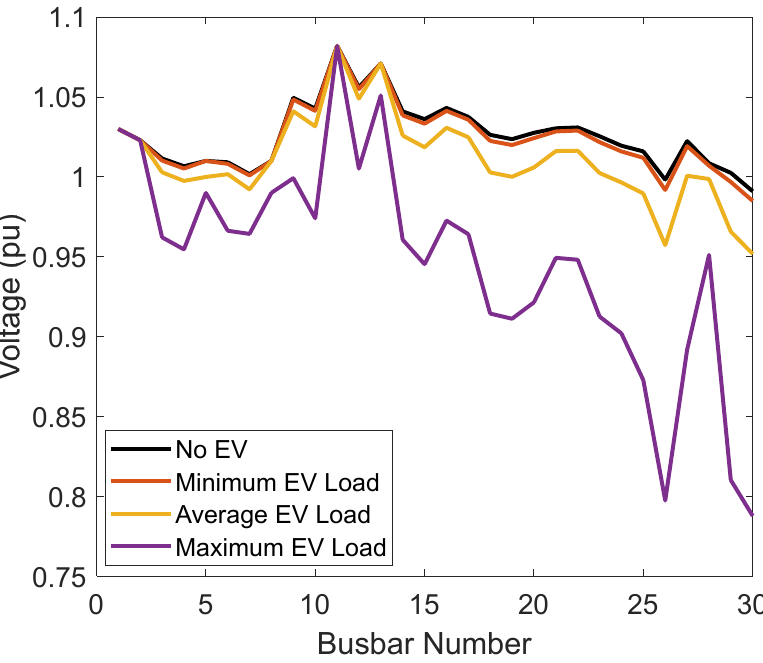
Figure 11. The voltage profile of the IEEE 30 bus system with the use of the SEVCS with different load variations without using the DR or the V2G concepts.